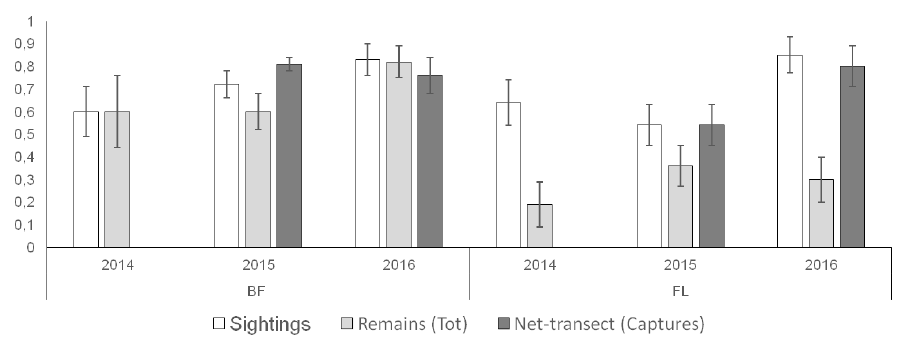
Figure 13. Detection probability values and relative standard error (SE) for the methods Sightings, Remains and Net-transect, in the two study areas Bosco della Fontana (BF) and Foresta della Lama (FL) in three years